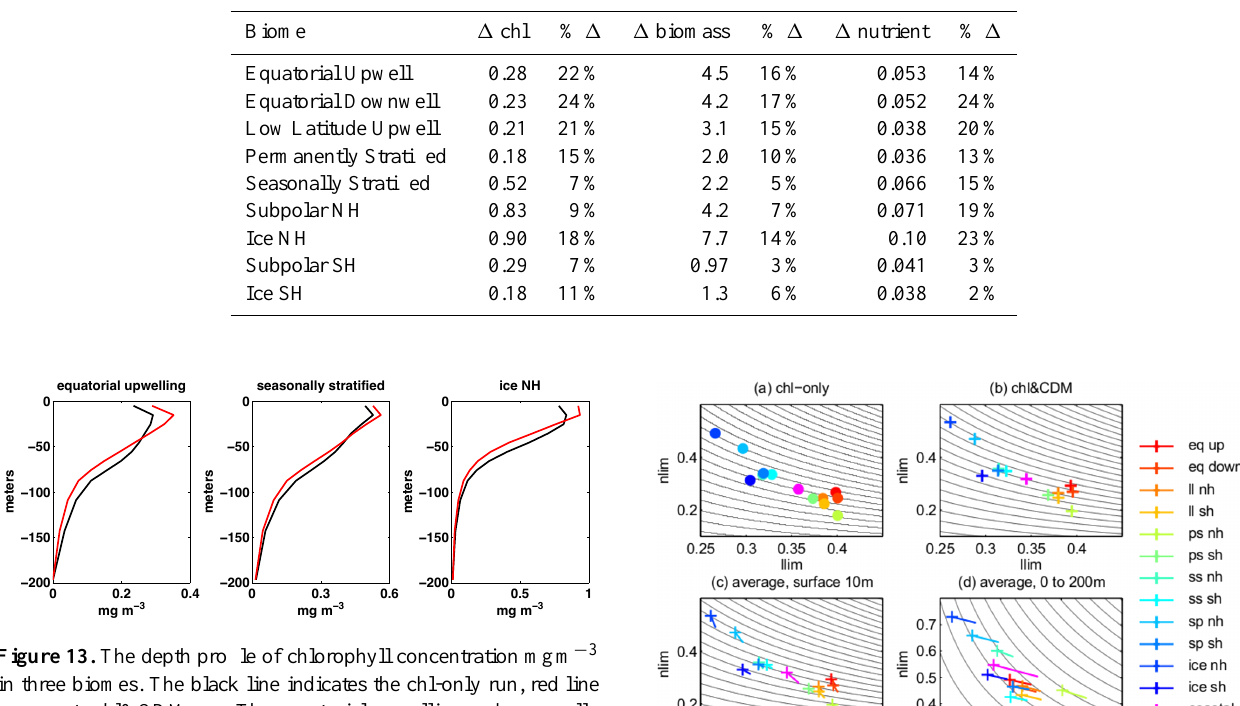
Table 2. Difference in surface chlorophyll mgm − 3 , biomass mgCm − 3 and macronutrient µM concentrations, chl&CDM minus chl-only. Surface values are the average over the top 10m. All surface changes are statistically significant to three standard deviations. Statistical significance tests were performed on decadally smoothed data from the final 100 years of the two model runs.